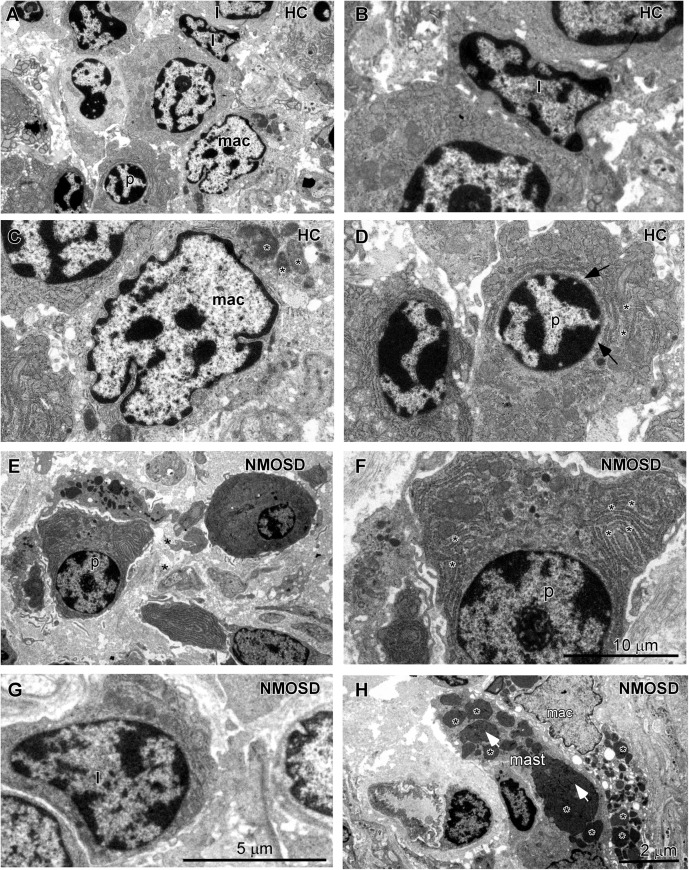
TEM photos showing changes in the morphology of inflammatory cells in the lamina propria of the colonic mucosa between subjects from two groups. (A) Different types of cells in the HC subjects included lymphocytes (l), macrophages (mac), and plasma cells (p). (B) High-power photo showing a representative lymphocyte (l) from panel (A). (C) High-power photo showing a representative macrophage (mac) from panel (A). (D) High-power photo showing a representative plasma cell (p) from panel (A). (E) Representative larger plasma cells (p) with rich cytoplasm surrounded by two macrophages in an NMOSD specimen. (F) High-power photo showing the plasma cell (p) from panel (E). (G) A representative larger lymphocyte (l) in an NMOSD specimen. (H) A representative macrophage (mac) with a larger number of particles and a mast cell (mast) in the colonic mucosa of an NMOSD patient. The scale bar (10 μm) in (F) is equal to that in (C,D). The scale bar (5 μm) in (G) is equal to that in (B). The scale bar (2 μm) in (H) is equal to that in (A,E).